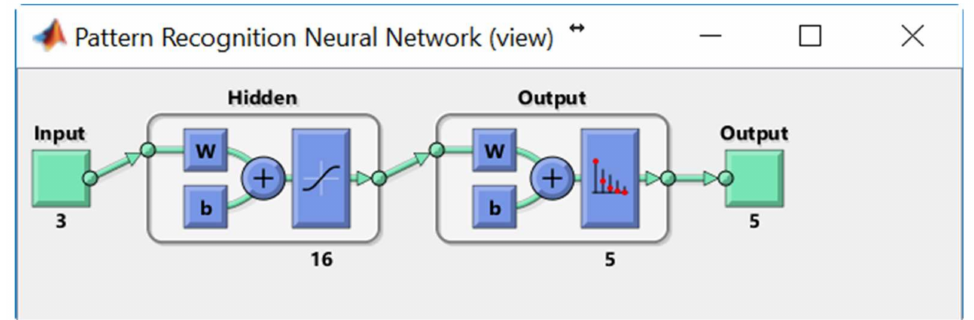
Figure 8. The architecture of Pattern Recognition Neural